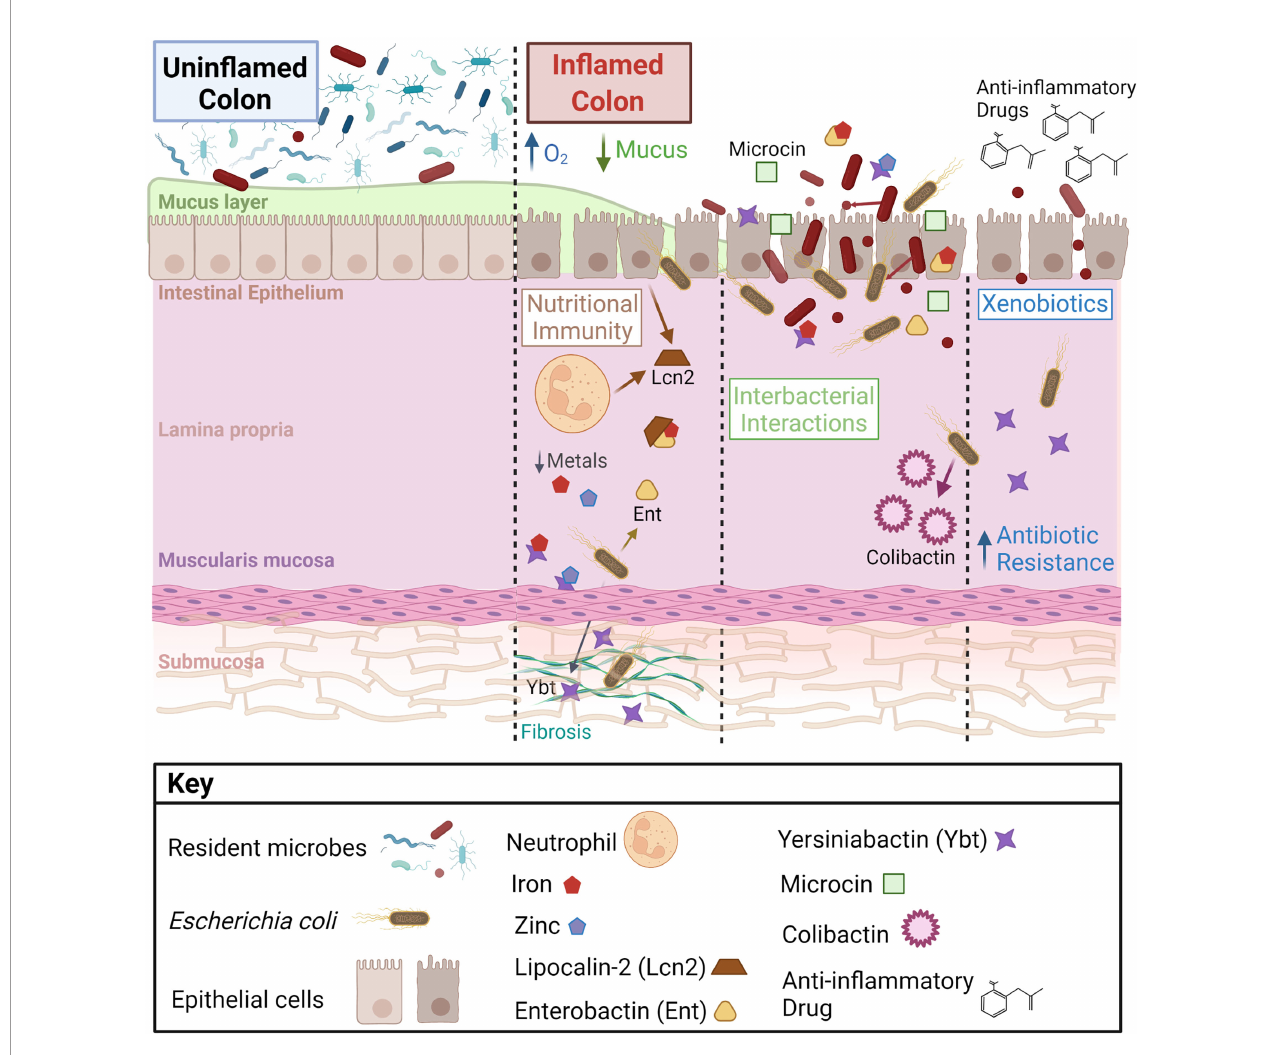
FIGURE 1 | Intestinal microenvironmental stressors that in fl uence bacterial metabolite production and disease on the host. During in fl ammation, increased epithelial oxygenation and mucus degredation is linked to a loss of gut microbial diversity and enrichment of Enterobacteriaceae , notably Escherichia coli. E. coli at the mucosal interface and within intestinal tissue respond to microenvironmental changes, which alters their disease-causing potential. Important factors affecting E. coli metabolite production in the gut include host in fl ammation, nutritional immunity, interbacterial interactions, and exogenous